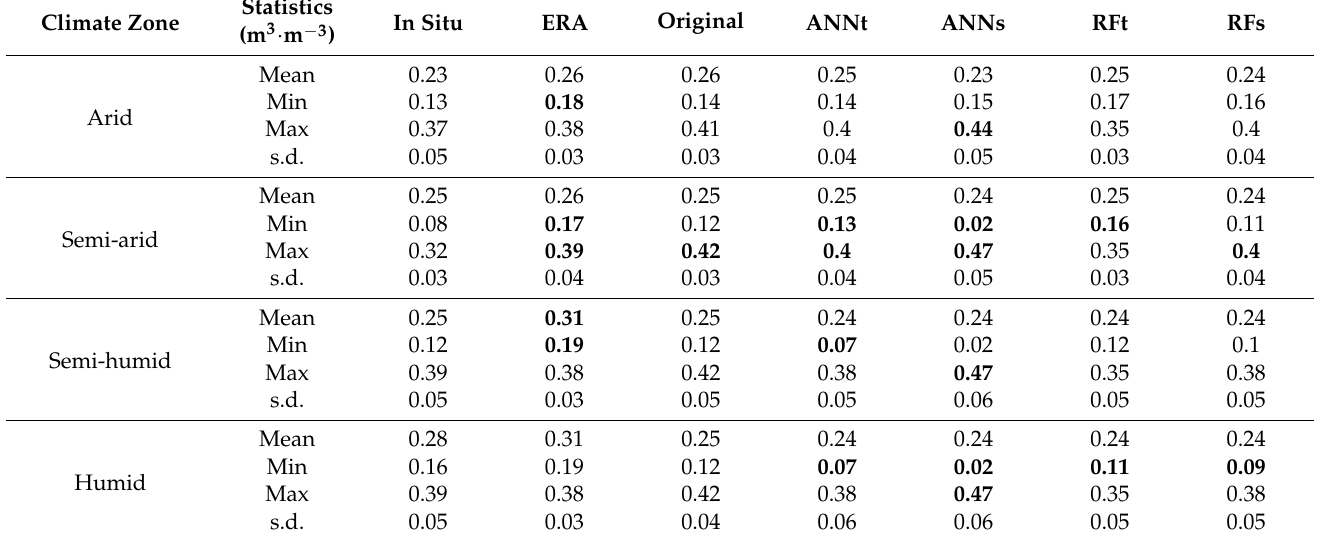
Table 1. Comparison of reconstructed soil moisture series against in situ soil moisture observations of the China agrometeorological stations and ERA